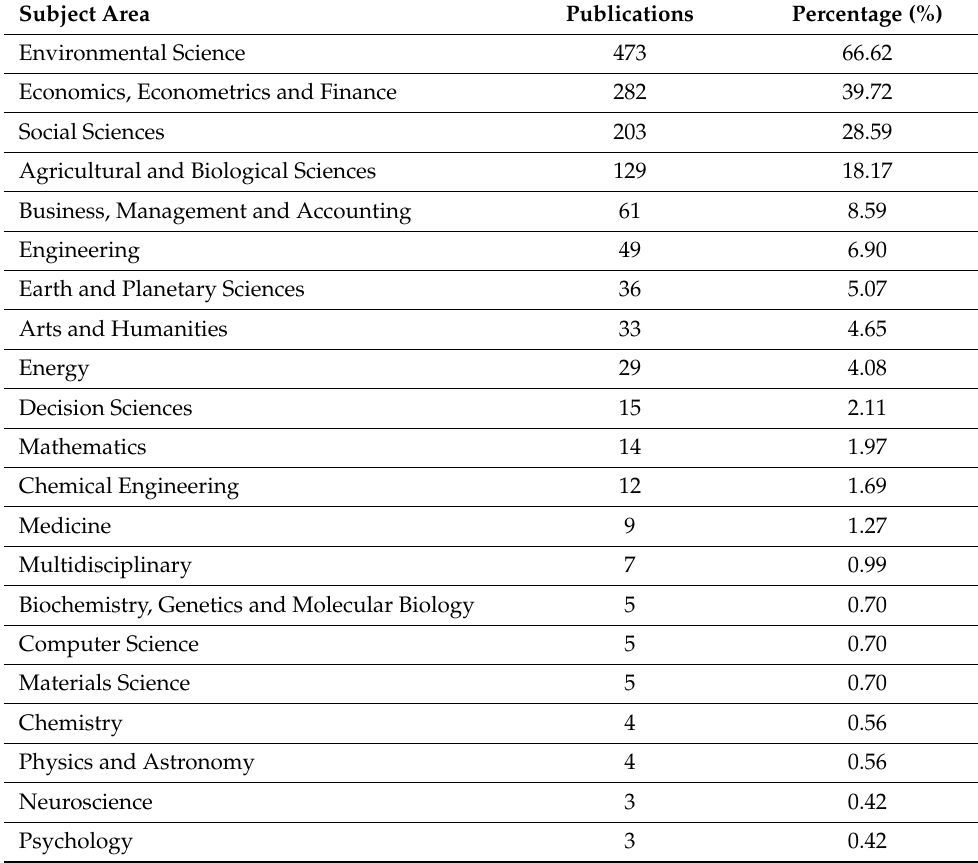
Figure 12. The pie chart for the research on environmental valuation. Table 6. Publications by subject area on environmental valuation